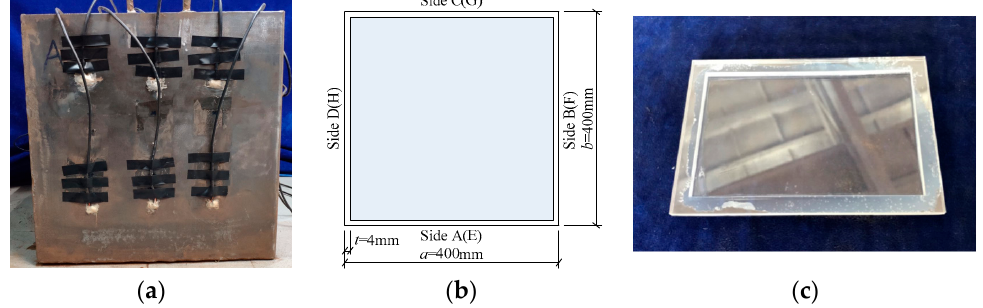
Figure 2. CFST specimen with surface-mounted PZT patches and its cross-sectional dimension (unit: mm). ( a ) Surface-mounted PZT patches; ( b ) cross-sectional dimension; ( c ) an acrylic plate.